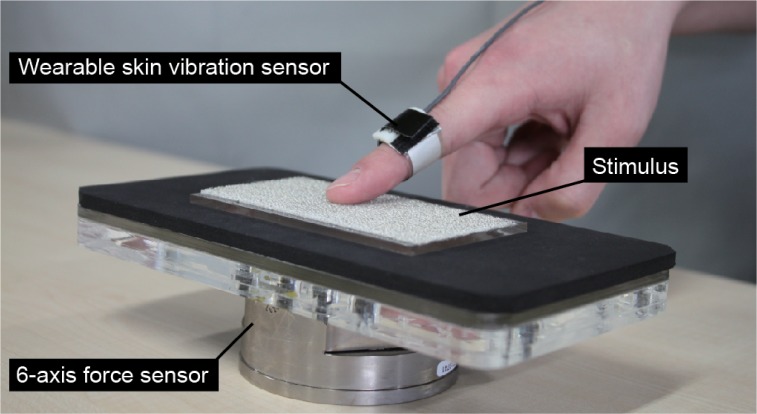
Experimental set-up.